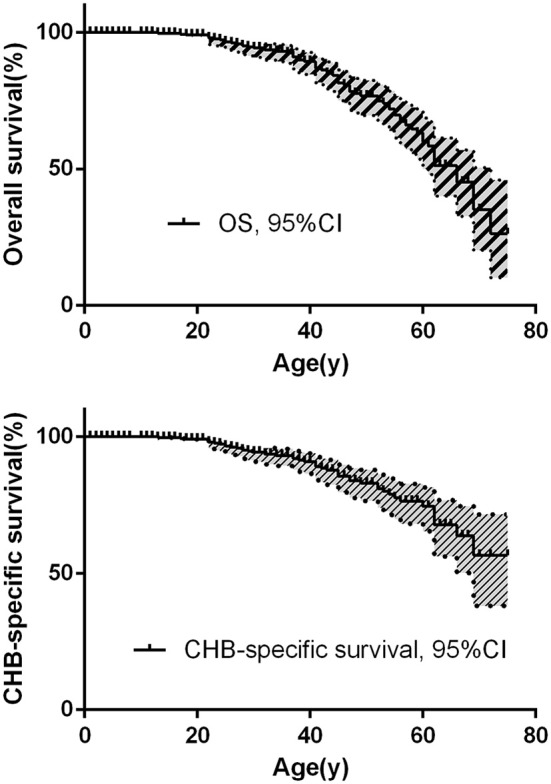
(A) The overall survival of VHL patients. (B) CHB-specific survival of VHL patients.